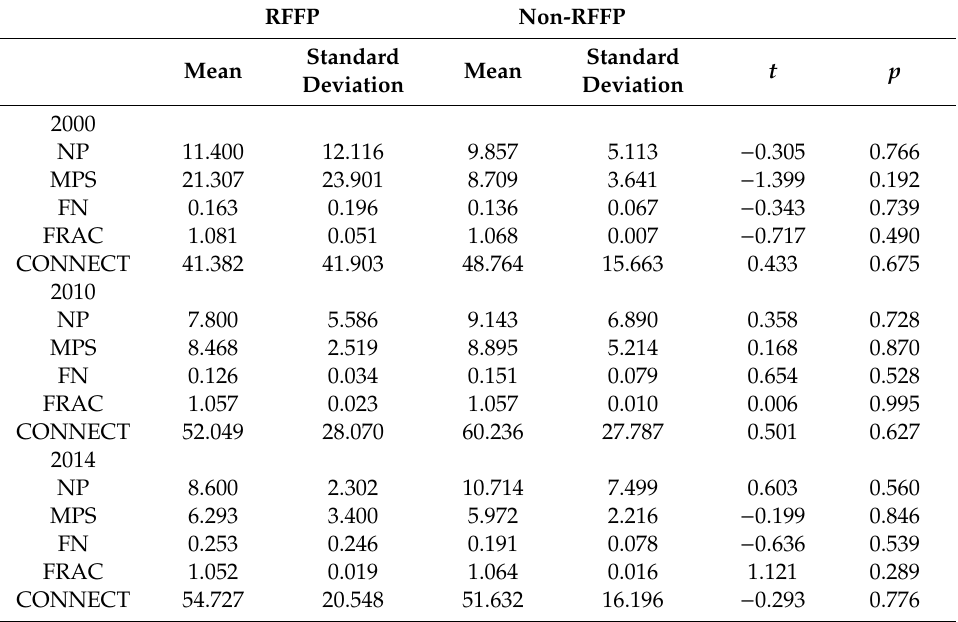
Refer to Table 3 for the abbreviations for landscape metrics.